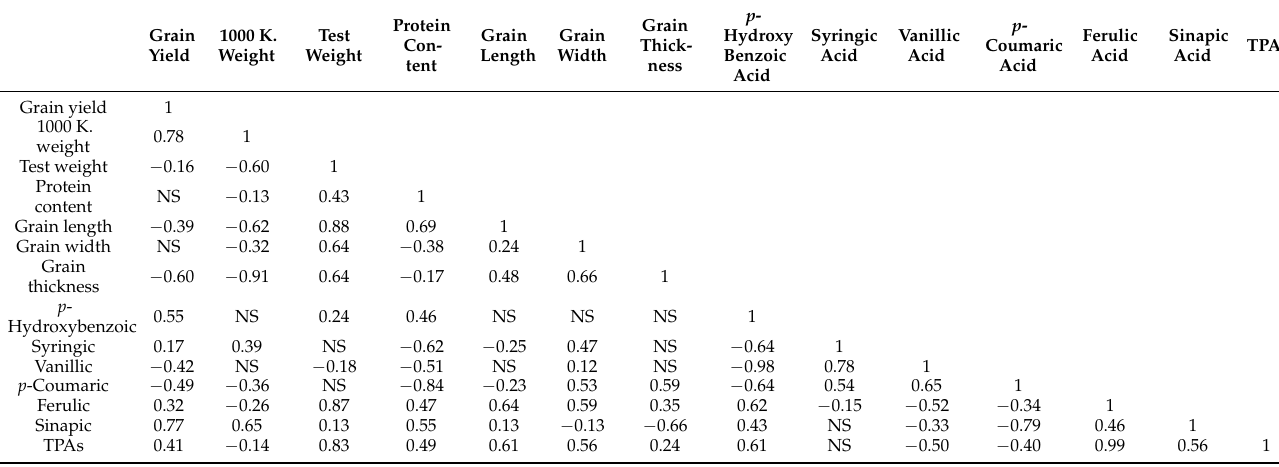
Table 3. Correlation coefficients ( r ) among individual phenolic acids (PAs) contents and other phenotypic traits including yield components protein content and kernel morphology and across year and growth conditions. TPAs: total sum of individual phenolic